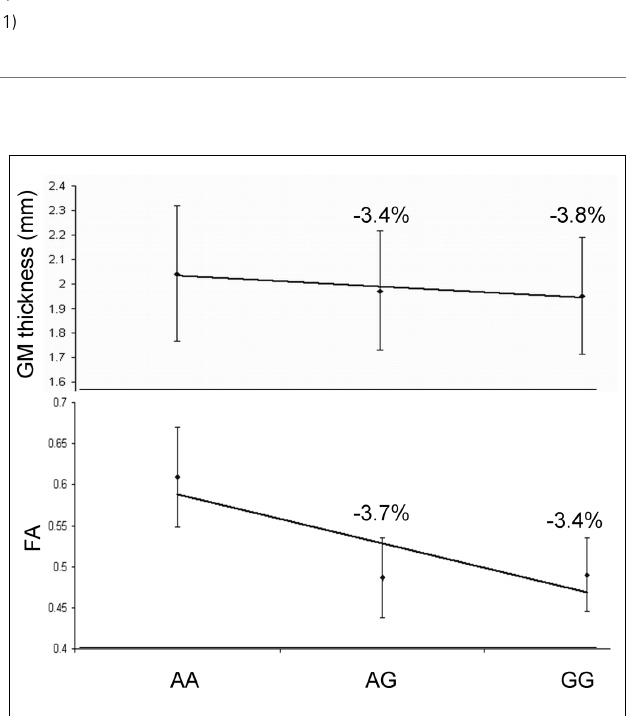
FIGURE 5 | Residual (corrected for age and sex) GM thickness and FA values for subjects with grouped by genotype for the rs2456930 polymorphism. The allele frequencies for this population were AA = 14.6%, AG = 48.3%, and GG = 36.9%.